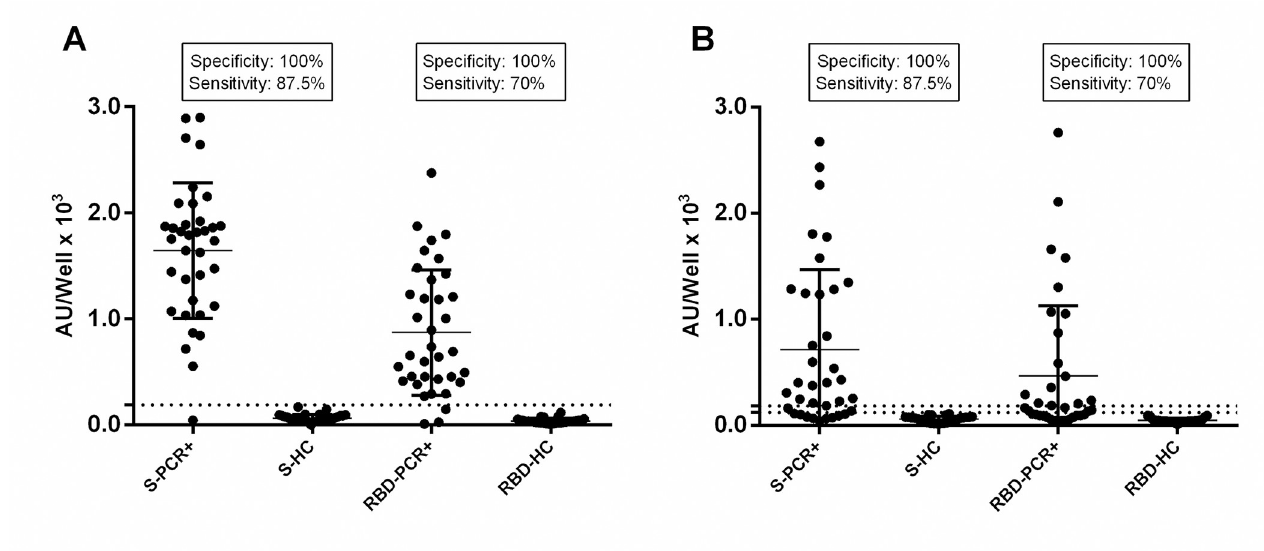
Fig 1. In-house ELISA validation. The sensitivity and specificity of the in-house ELISAs for IgG (A) and for IgA (B) Abs against S and RBD were estimated with 40 pre-pandemic sera (Healthy C.) and 40 PCR+ COVID-19 sera. For IgG anti-S and anti-RBD Abs the cut-off point was 150 AU/well (dashed line). For IgA Abs the cut-off point for anti-S was 120 AU/well and for anti-RBD 80 AU/well (dashed lines).